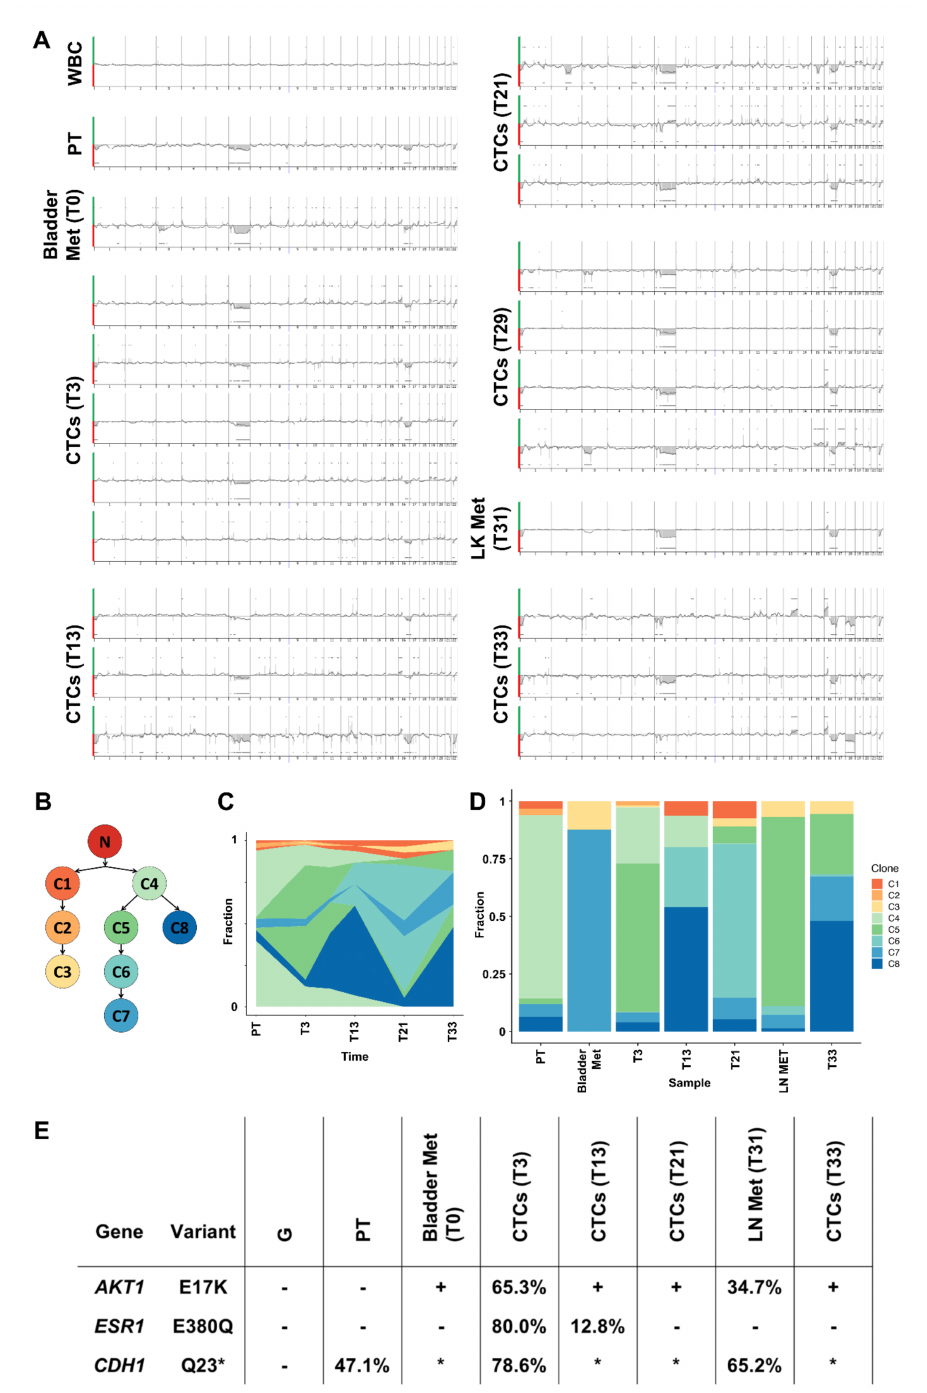
Figure 3. Clonal evolution of the tumor of patient 1: ( A ) Chromosomal aberrations as determined by array comparative genome hybridization. Green indicates a signal above the baseline representing a copy number gain. Red indicates a signal below the baseline representing a copy number loss. ( B ) Clonal reconstruction from the whole-exome sequencing data revealed eight tumor clones. ( C , D ) Clonal dynamics of the tumor cell clones during the course of the disease. ( E ) Presence and dynamics of clinically relevant mutations. Values indicate variant allele frequencies. Positive results (no allele fraction) come from Sanger sequencing (Supplementary Table S2). * The CDH1 Q23 position was not covered by whole-exome sequencing on amplified DNA samples. No information about the mutational status in those samples is available. CTC (circulating tumor cell); WBC (white blood cell); PT (primary tumor); LN (lymph node); Met (metastasis); G